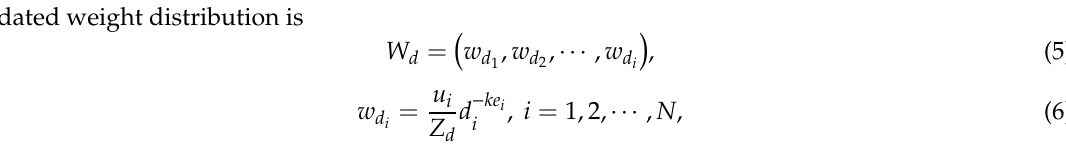
Table 1. Weights for different distance panes.